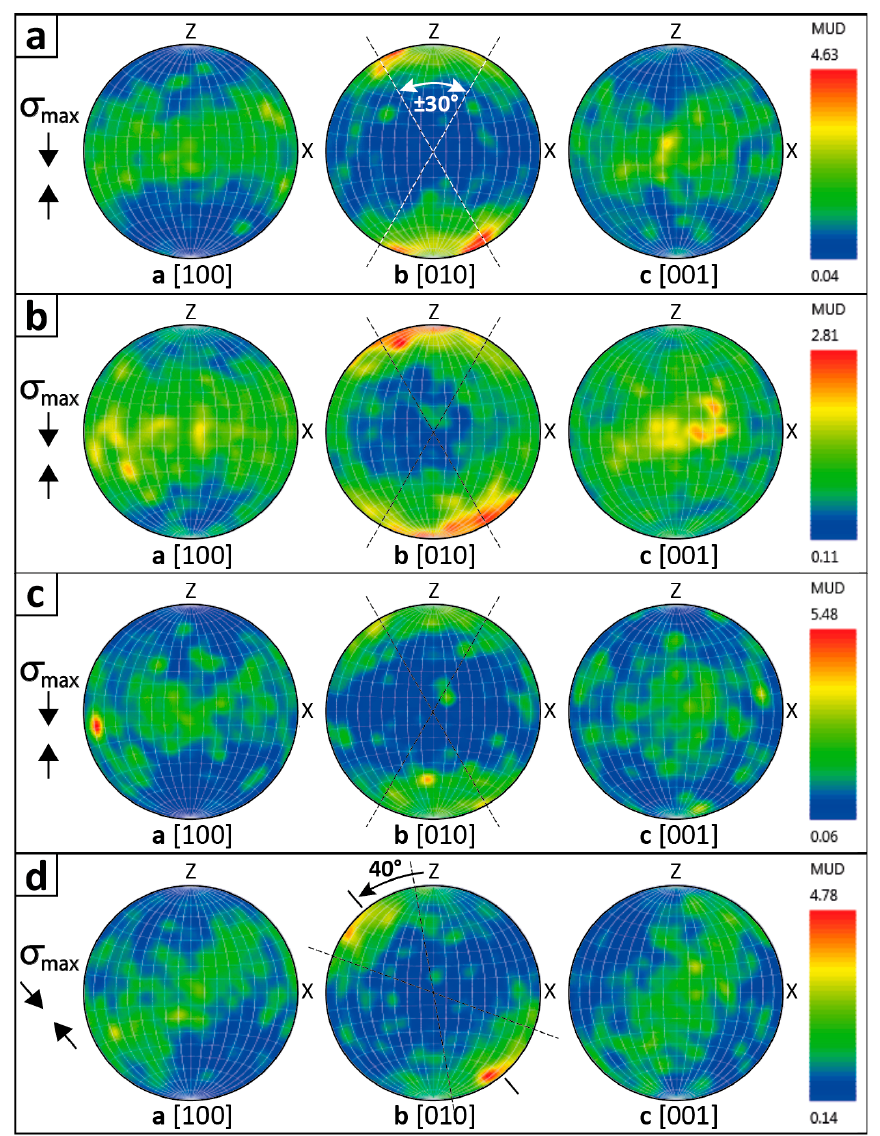
Figure 11. Electron backscatter diffraction (EBSD) pole figures on deformed samples. ( a ) Run KG-329, starting material SP-313-1, T = 1002 °C, σ max = 110 MPa (15,793 analysis points); ( b ) Run KG-322, starting material SP-310-1, T = 1056.5 °C, σ max = 55 MPa (33402 analysis points); ( c ) Run KG-330, starting material SP-313-2, T = 1105.5 °C, σ max = 105 MPa (29,215 analysis points); ( d ) Same as ( c ) but data collected near a corner of the sample, where the stress field turns with σ max oriented ≈ 40° from the vertical axis (80,078 analysis points). In any case, the b-axis tends to orient in a direction ±30° to the compressive stress. Upper stereographic projection. MUD = multiples of uniform distribution. Indexation: 55-80% ( ≈ 99% Fo + ≈ 1% oEn). The Z direction is parallel to 𝜎 (cid:2869) . Lower hemisphere. For acquisition conditions, see Table S4. The increase in transformational strain with decreasing grain size commonly indi- cates the importance of GB effects, such as the occurrence of GBS [151]. In this study, the